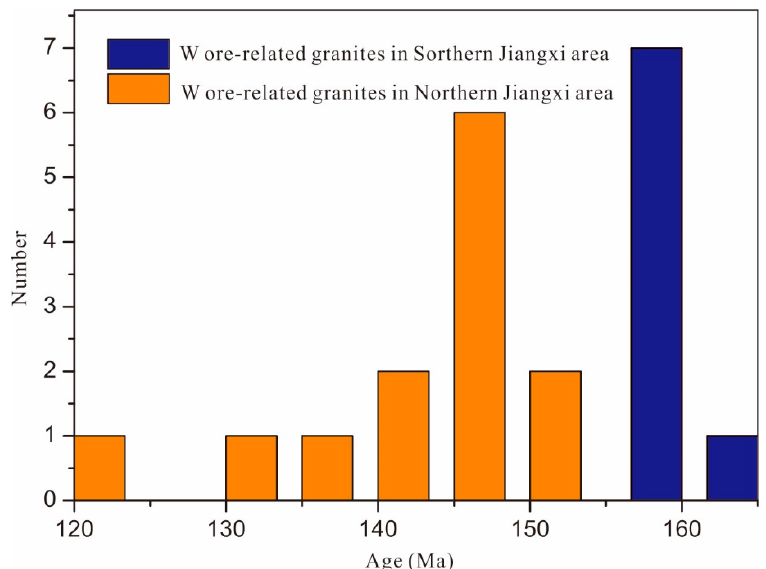
Figure 8. Histogram of granite ages in Jiangxi Province. Age data are listed in Table 3.